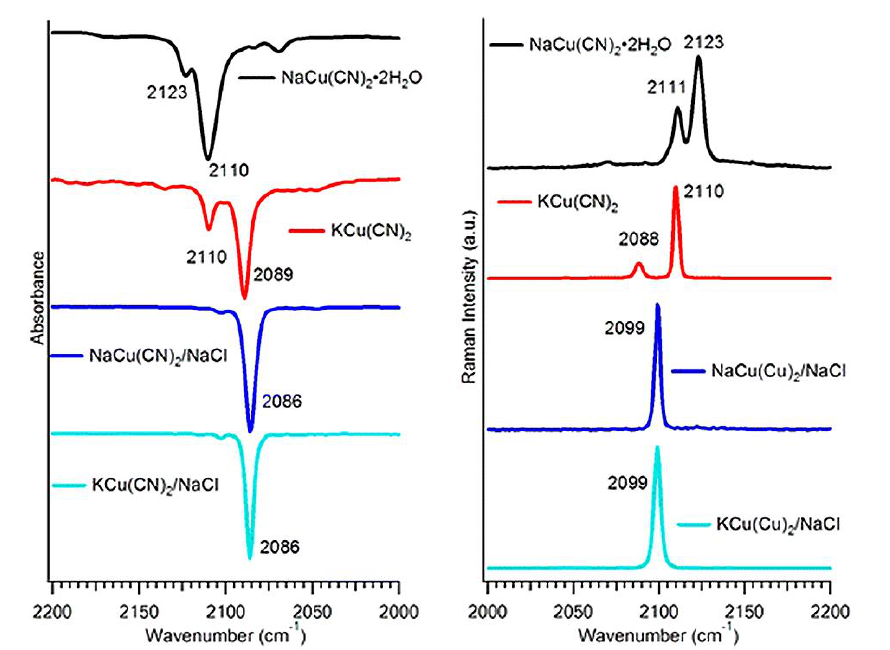
Figure 8. Luminescence spectra at 77 K of ( a ) NaCu(CN)